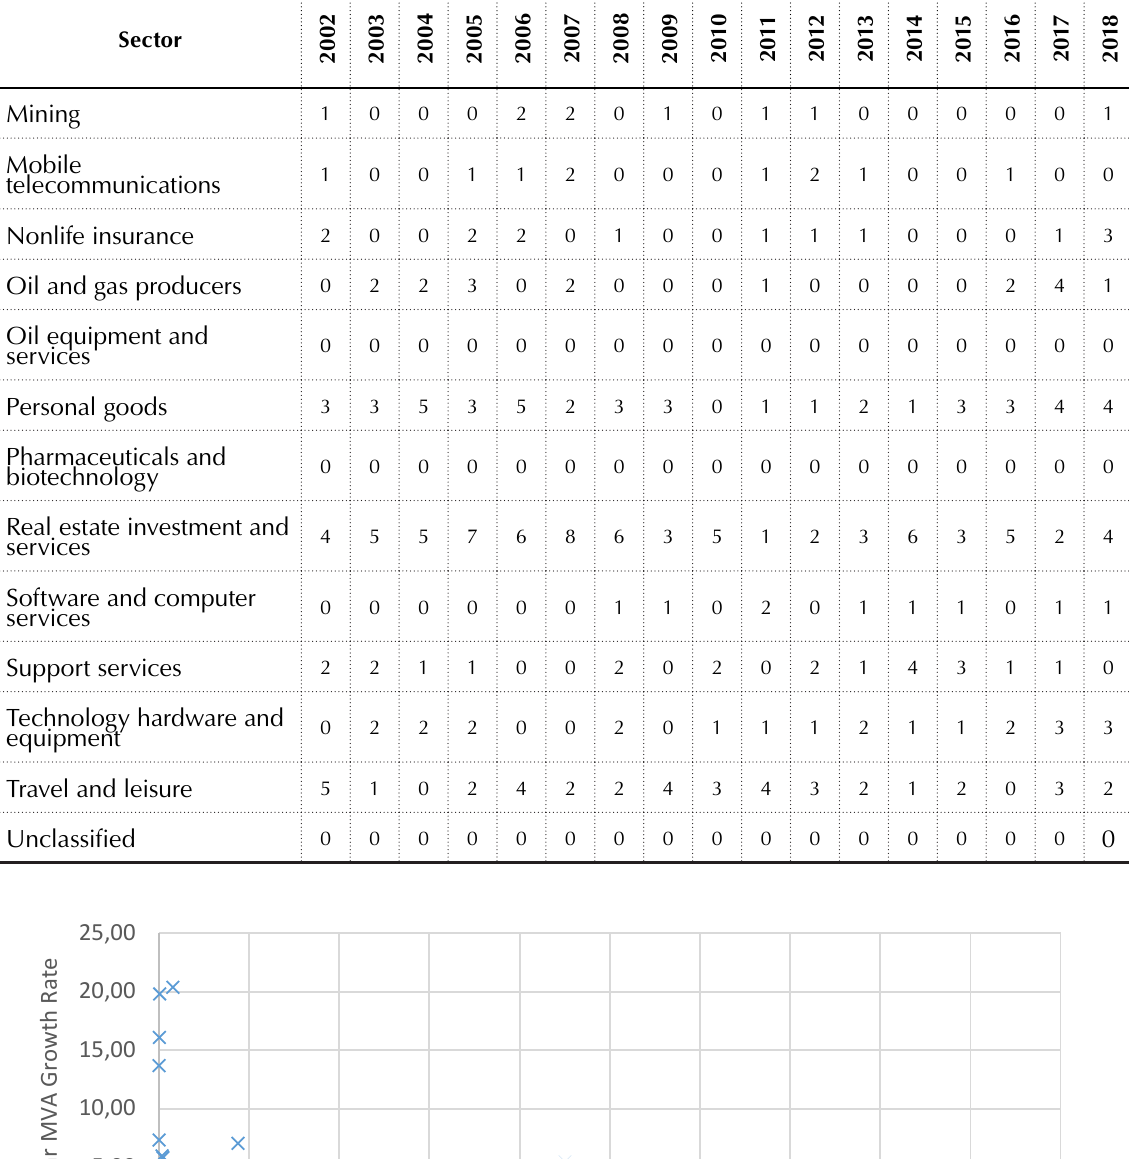
Table 9 (cont.). The industrial sector of top 50 three-year growth rate of market adjusted change of MVA stocks Sector